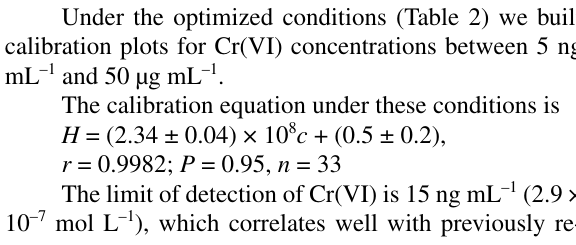
= 5 cm and 2 , D = 29 p p = 5 cm, 2 , D = 10 cm, and 3 , D = 29 p p p